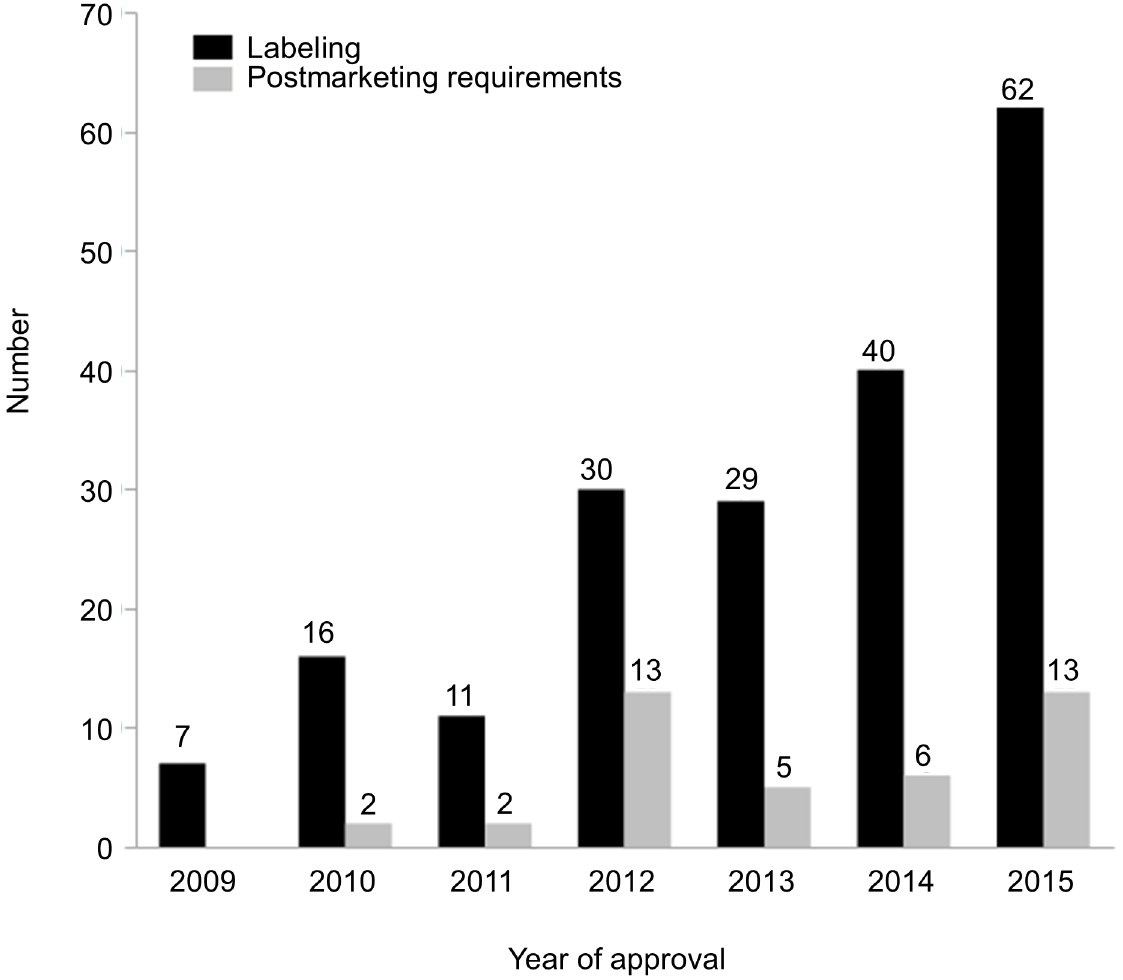
Fig 4. The numbers of SMQ searcheswhich directly impacted regulatory decisions per year of approval. The regulatory decisionshereinrefer to those associated with labelingand postmarketing requirements. A single search may have an impact on both regulatorydecisions.SMQ,